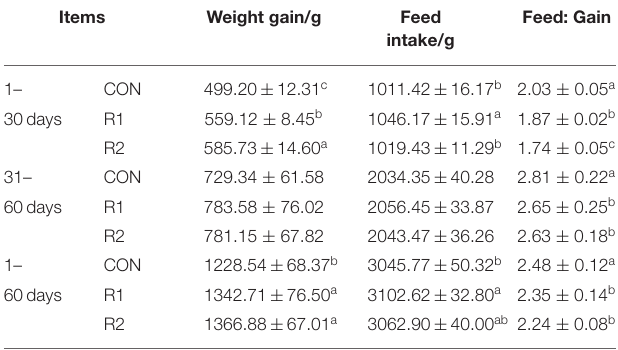
TABLE 4 | Effects of catalase (CAT) on growth performance of yellow broilers.